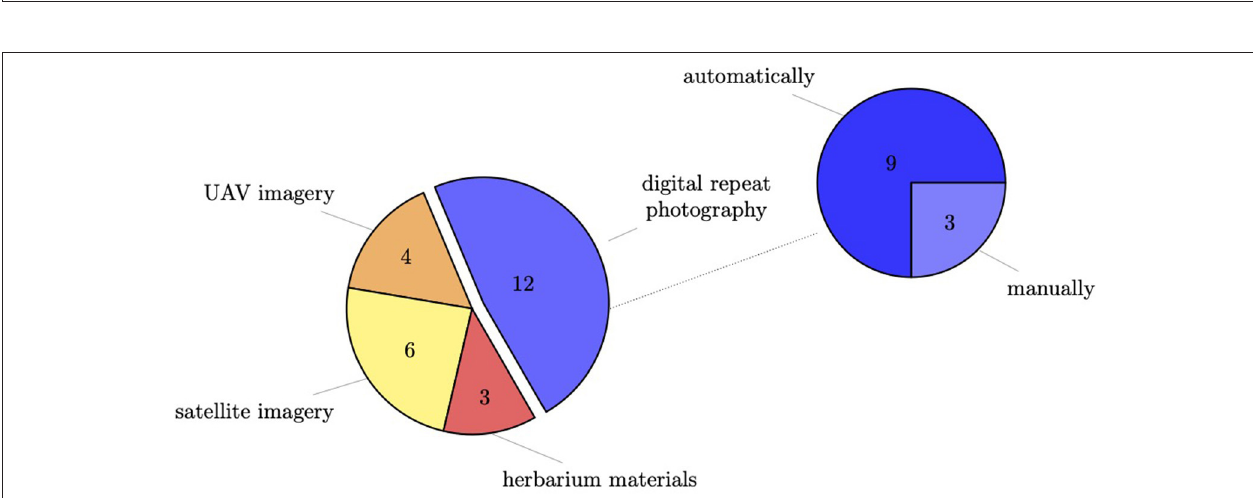
FIGURE 5 | Utilization of different methods for acquiring training data across primary studies.